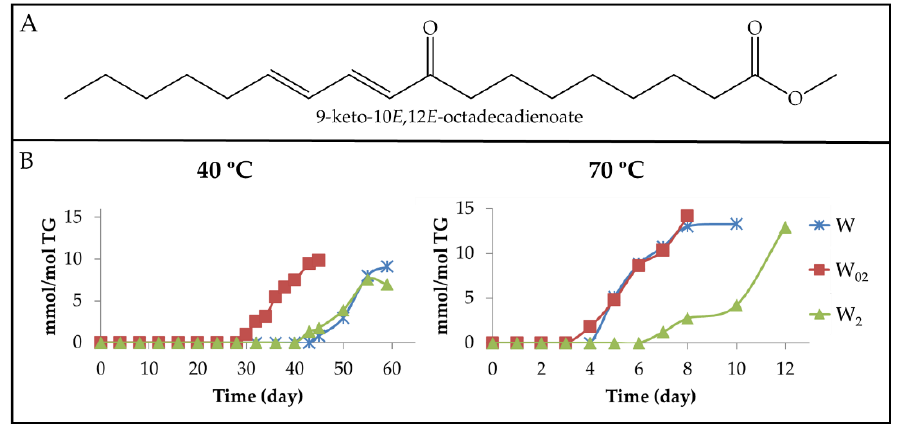
Figure 11. ( A ) Structure of 9-keto-10 E ,12 E -octadecadienoate as an example of mKO-c( E , E )-dE. ( B ) Evolution of the concentration expressed as mmol/mol TG, of mKO-c( E , E )-dEs in walnut oil with different enrichment levels of αT (W, W 02 and W 2 ), submitted to either 40 °C or 70 °C, up to advanced stages of the oxidation process.